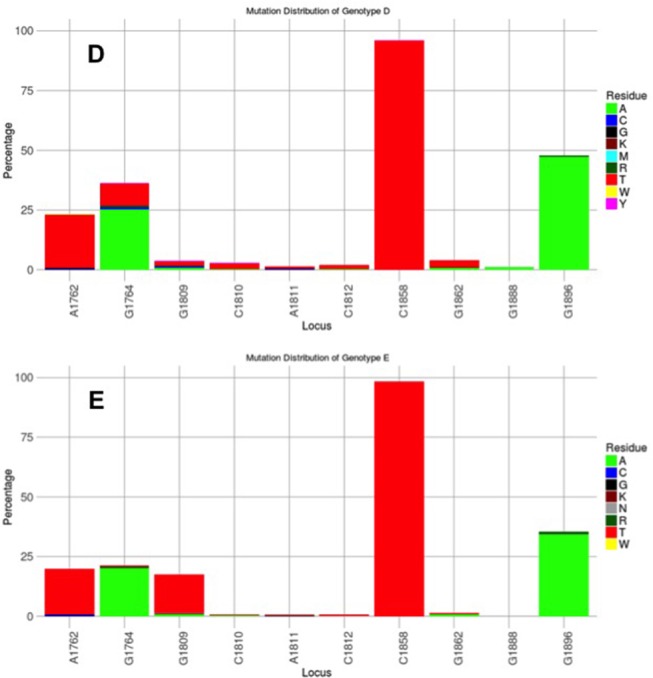
Mutation distribution graphs generated using the Mutation Reporter Tool (Bell and Kramvis, 2013) showing the percentage of mutant residues relative to the reference motif found at the ten loci of interest specified (1762, 1764, 1809-1812, 1858, 1862, 1888, 1896). Two data sets were submitted to the tool to produce the two graphs showing the mutation distribution for 1899 genotype D and 471 genotype E unselected sequences. The basic core promoter/precore sequences (1750–1900 from EcoR1 site) was downloaded from http://hvdr.bioinf.wits.ac.za/alignments (Bell et al., 2016). The reference motif used was AGGCACGGGG. This is also shown by the letter preceding each locus on the X-axis. To facilitate direct comparisons between the graphs, conserved loci were not suppressed and the Y-axis was scaled to 100% by selecting the appropriate controls on the input page.